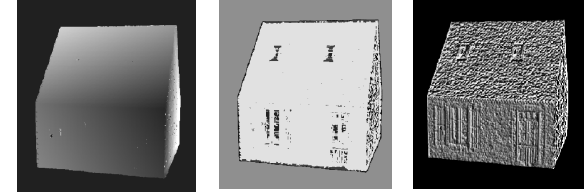
Figure 3: Dicho1D results obtained on Bergerie1 with Medicis_V11.0: disparity map on the left, validity flags in the middle, error on the right (with error=sqrt[(GTx – Dx)²] as Dy=0 for Dicho1D). Exploring in 1D instead of 2D also saves computational time.